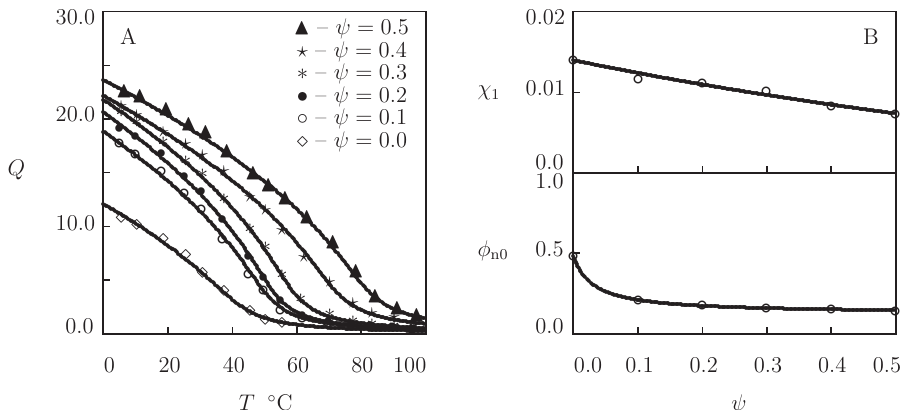
Figure 13. ( A ) Degree of swelling Q versus temperature T . Symbols: experimental data [104] on P(MEO 2 MA–OEGMA 475 ) gels with various molar fractions ψ of OEGMA monomers. Solid lines: results of simulation. ( B ) Parameters χ 1 and φ n0 versus molar fraction of OEGMA monomers ψ . Circles: treatment of observations. Solid lines: results of